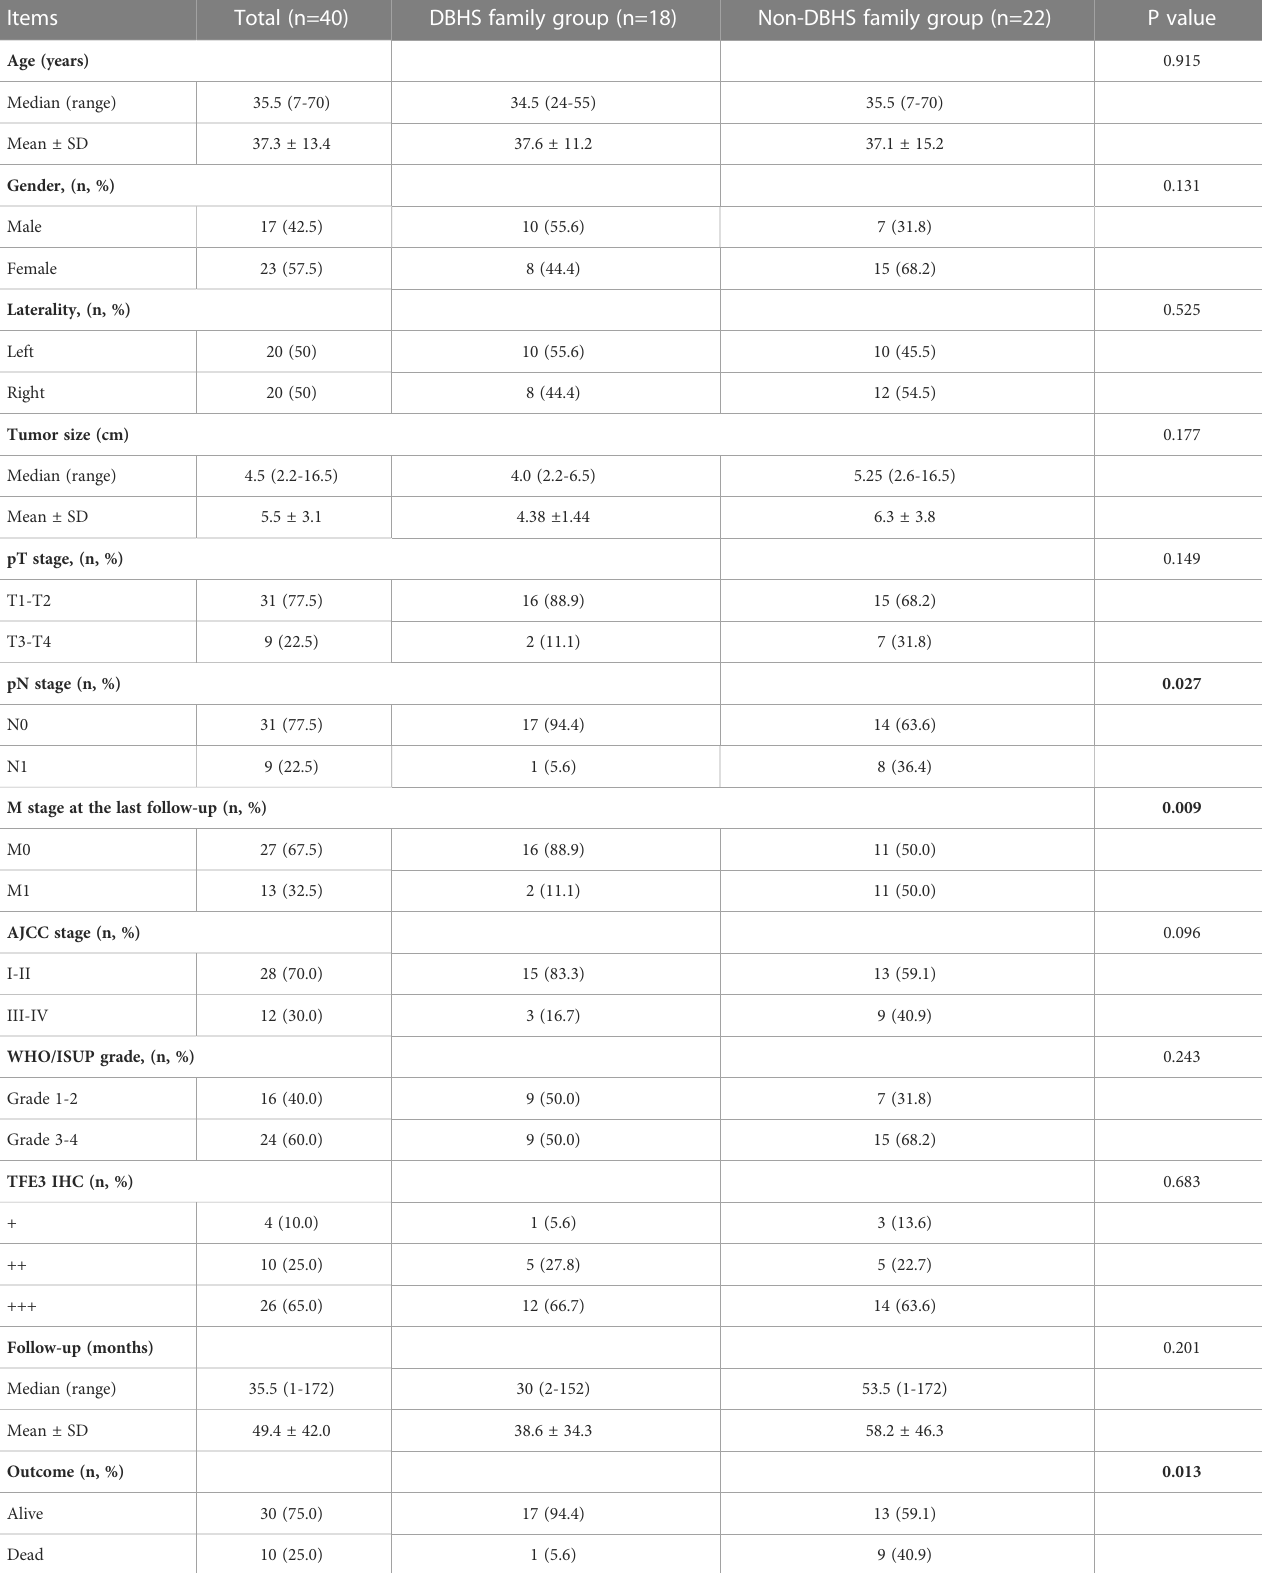
TABLE 3 Comparison of clinicopathological features between DBHS family group and non-DBHS family